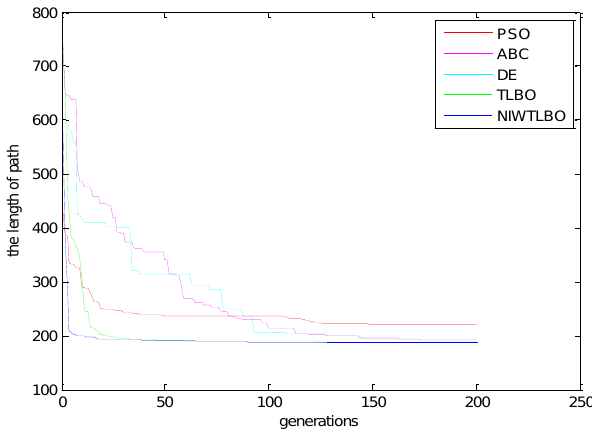
Figure 4. The comparison of the optimal convergence graph.